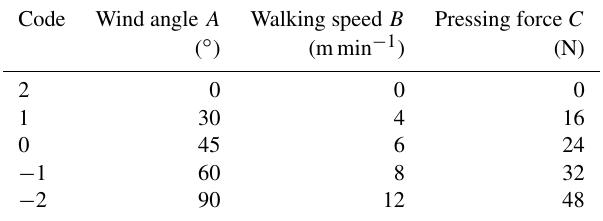
Table 3. Level and code of variables chosen for central composite design.